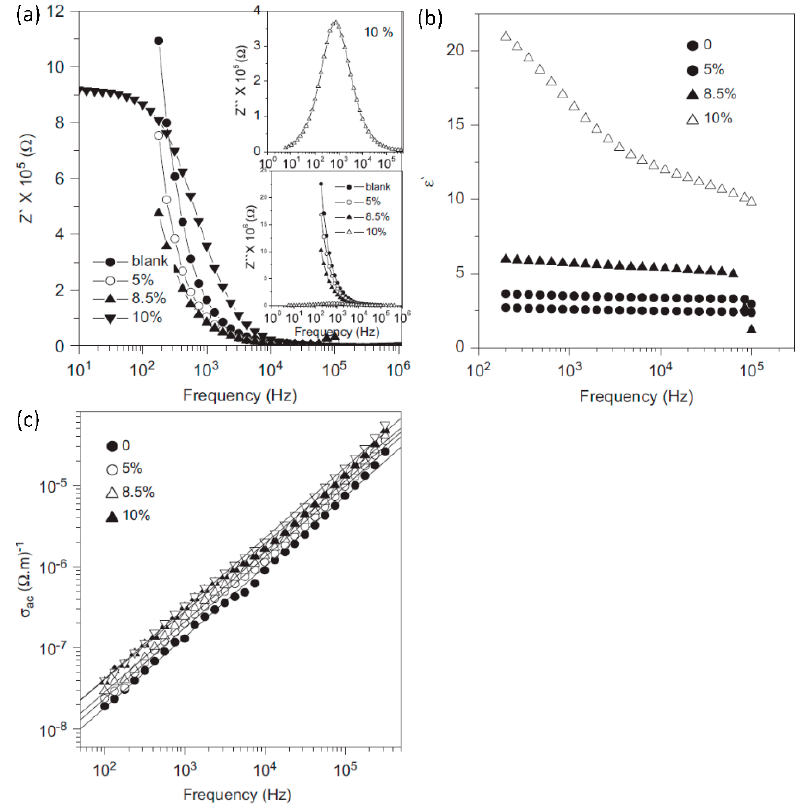
Figure 5. Variation of ( a ) the real and imaginary impedance, ( b ) dielectric constant, and ( c ) AC conductivity with frequency for MWCNT / PMMA composite with varying amounts of MWCNT. σ AC was obtained by subtracting σ DC from the total conductivity [1].